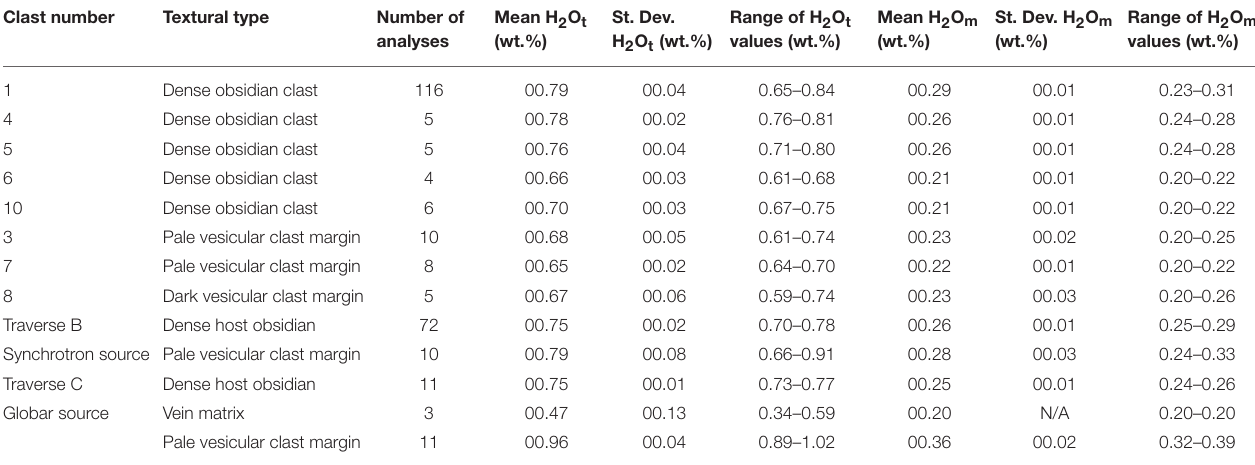
TABLE 3 | Summary of clast H 2 O concentrations as measured via